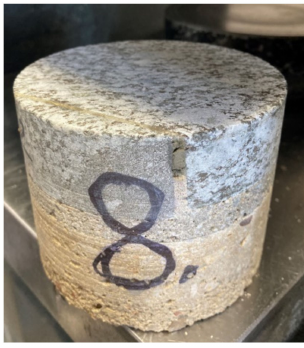
Figure 5. Core concrete sample No. 8 (borehole diameter 98